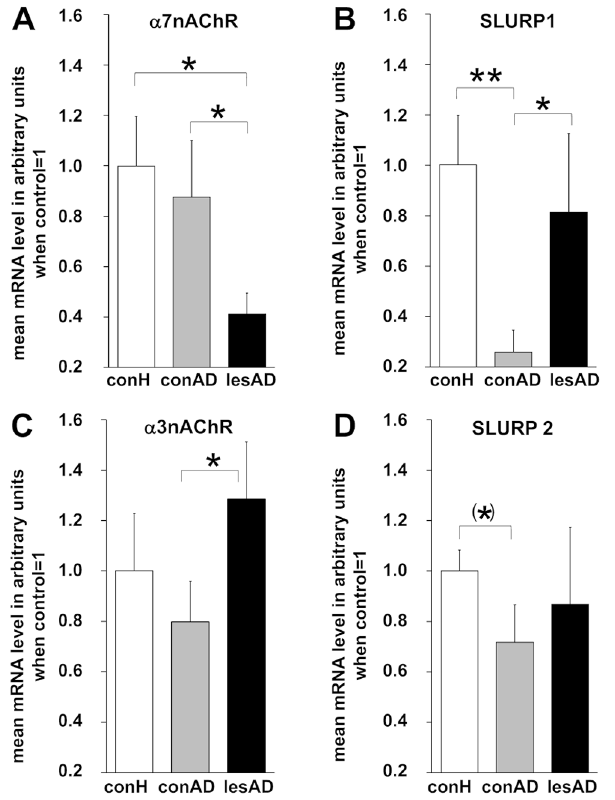
Figure 2. SLURP and selected SLURP receptor levels in healthy, non-lesional and lesional AD skin. Quantitative RT-PCR was performed on full thickness skin biopsies. Participants per group: eight (six male, two female). Corresponding raw data is provided as Data S1 . P-values: , 0.10 5 (*), , 0.05 5 *, , 0.01 5 **. Abbreviations: conH – healthy control skin, conAD – non-lesional AD skin, lesAD – lesional AD skin.